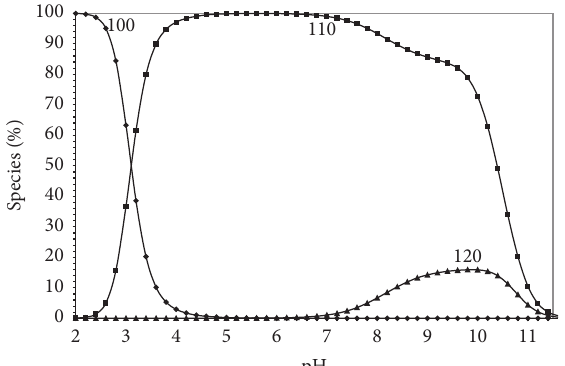
Figure 8: Concentration distribution of various species as a function of pH in the Zn-DMPTHP system (at concentrations of 1.25mol · dm − 3 for Zn(II) and 1.25mol · dm − 3 for DMPTHP) at 25 ° C and I � 0.1mol · dm − 3 NaNO 3 .